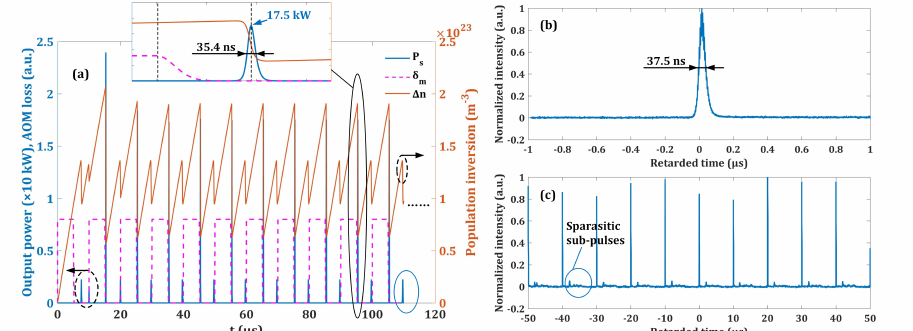
Figure 5. ( a ) simulation of temporal evolution of output laser power, average intracavity population inversion and acoustic-optical modulating loss, and the insert shows the detail of pulse producing. The insert shows the detail of a stable pulse, which is consistent with ( b ) the experimental measured pulse shape within a tolerable error; ( c ) the experimental temporal scope trace of output pulse sequence.